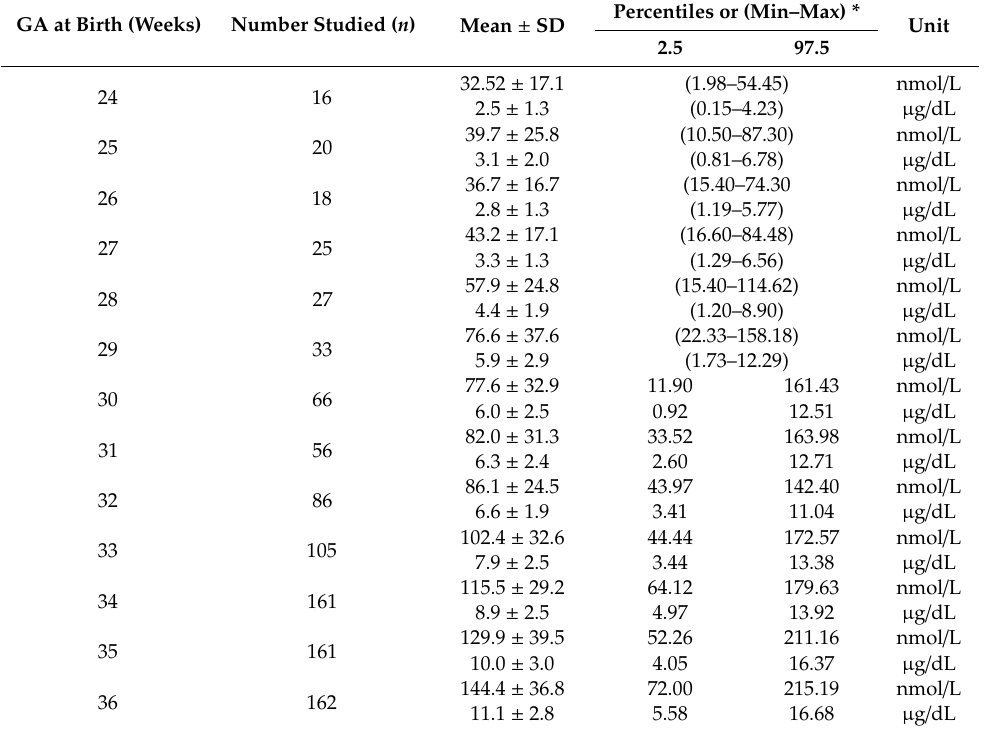
Figure 3. tT 4 concentration (nmol / L) in relation to gestational age. Circles represent outliers, and stars extremes. Table 3. Mean tT 4 concentration and percentiles for premature-born infants.